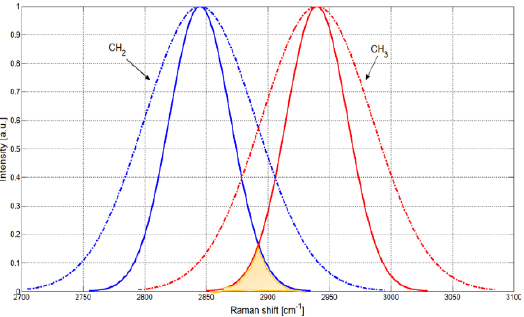
Fig. 3. Raman bands for CH 2 (2845 cm -1 , red circles) and CH 3 (2940 cm -1 , blue